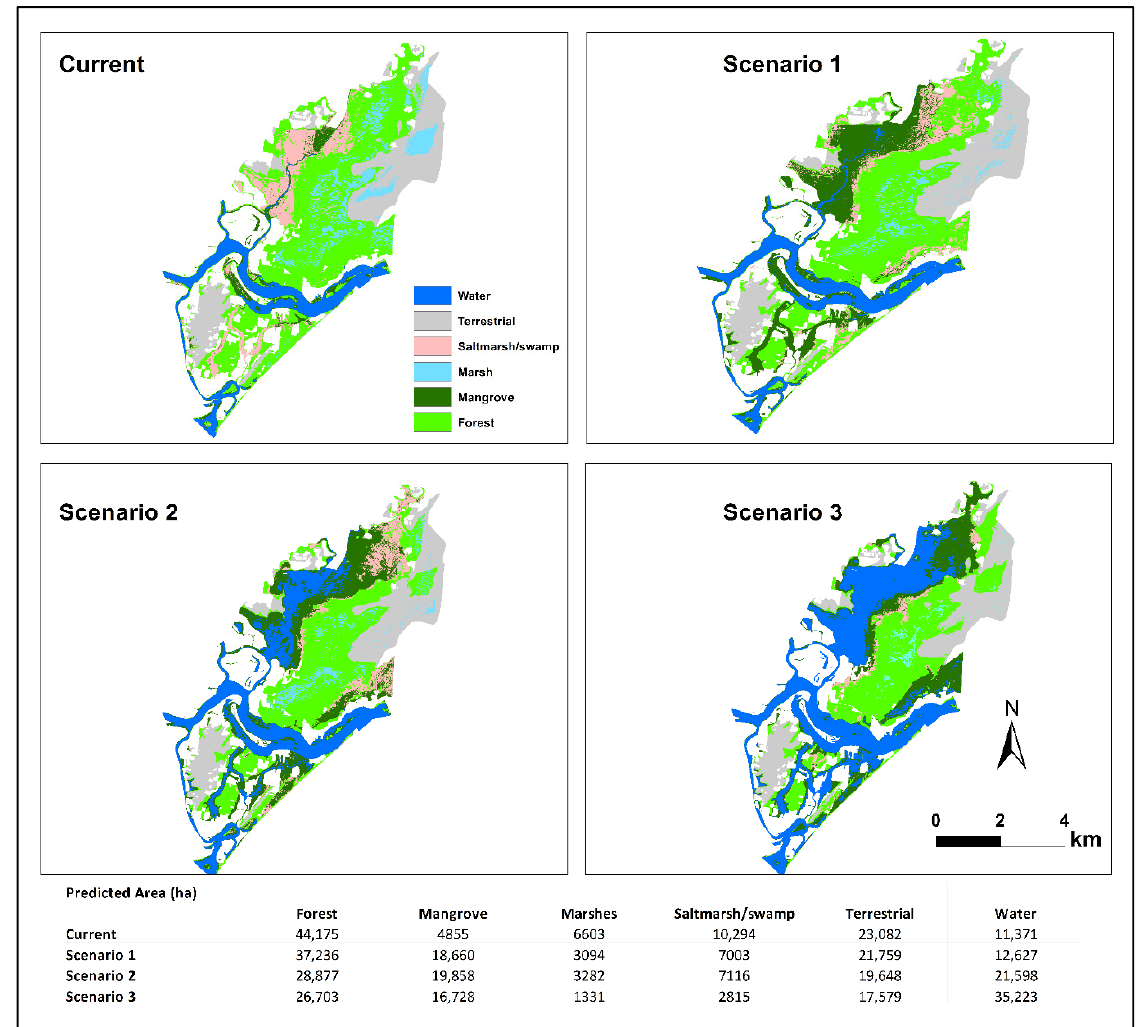
Figure 3. The predicted land-cover maps showing the current and future distributions of major wet- land types under three sea level rise scenarios (SLR scenarios 1, 2, and 3 correspond to 0.5 m, 1.0 m, and 1.5 m SLR, respectively) in the focused study area of the Manning River Estuary. The areas of predicted land cover are also listed.